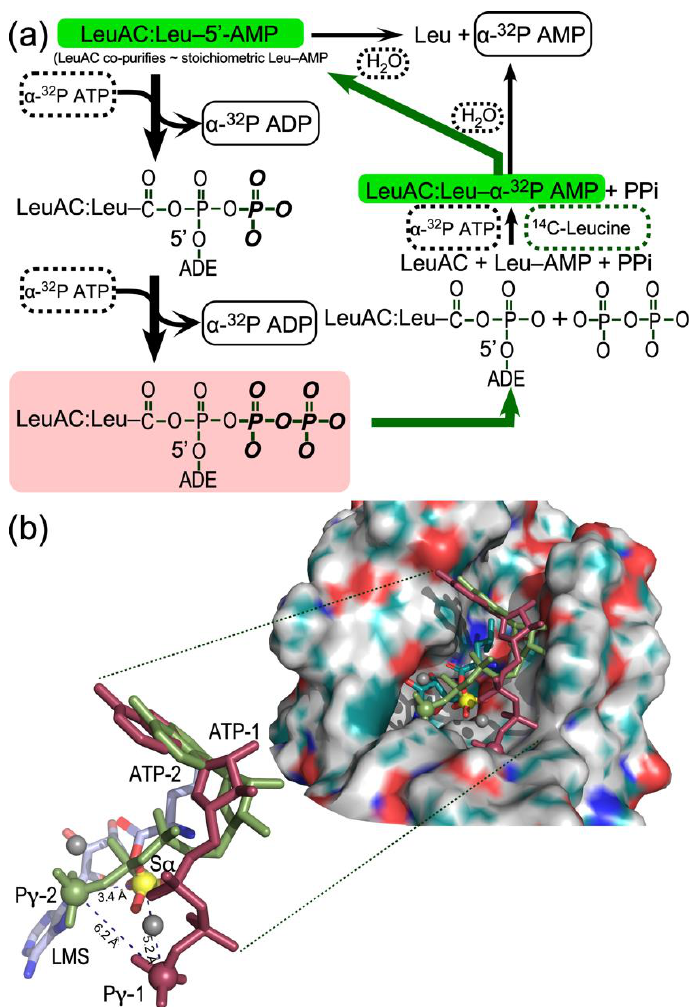
Figure 9. ( a ). Kinetic scheme accounting for formation of non-canonical sur-stoichiometric ADP (bold black arrows) and the incorporation of [ 14 C] leucine into bound leucyl- 5′ AMP (bold green ar- rows, green background). Reactants — ATP, leucine, and water — are enclosed by dashed rectangles; products — ADP, AMP, and leucyl- 5′ AMP — by solid rectangles. ADE represents adenosine. The rose